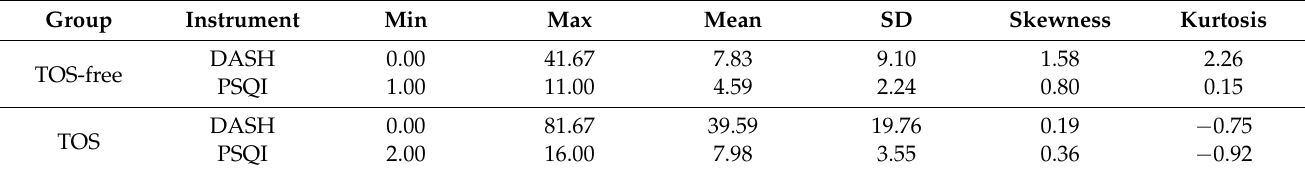
Table 3. Descriptive statistics related to the DASH and PSQI